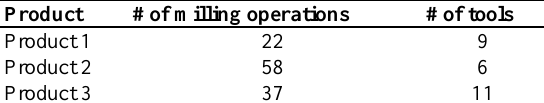
Table 5. Operational requirements of the products.